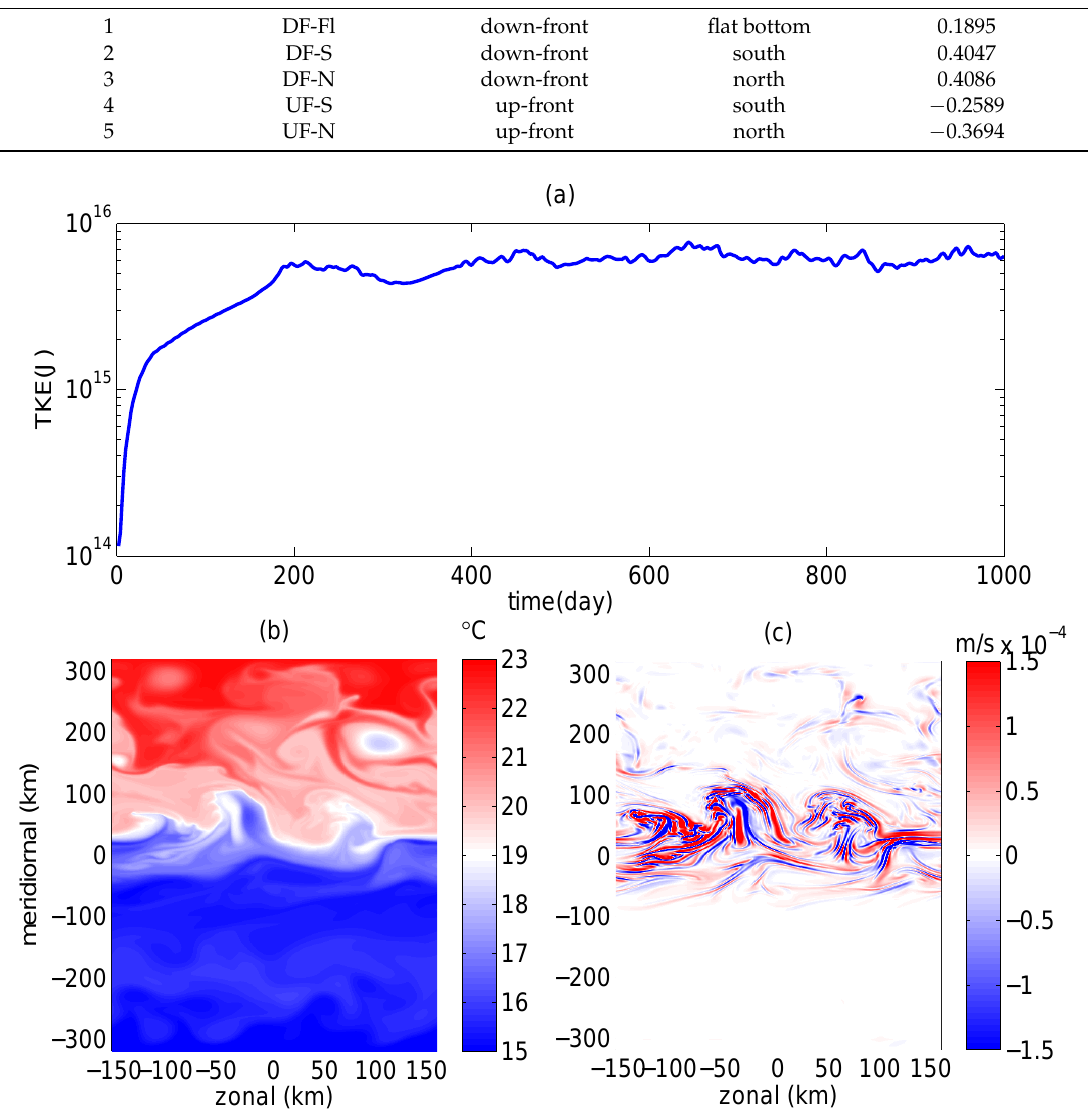
Figure 3. ( a ) Growth of total kinetic energy in Experiment DF-S. ( b ) Snapshots at day 900 for Experiment DF-S (Table 1) surface potential temperature ( ◦ C) at 10 m depth. ( c ) Same as ( b ), for vertical velocity w (10 − 4 m s − 1 ) at 30 m